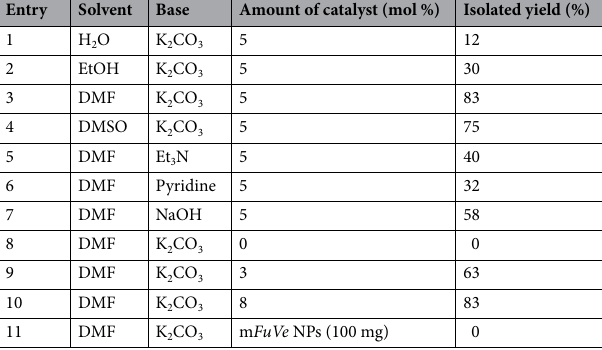
Table 1. Optimization conditions of the synthesis of N -cyclohexyl-2-(4-methyl-1-oxoisoquinolin-2(1 H )-yl)- 2-phenylacetamide. Reaction conditions: Compound 6 (0.3 mmol), base (0.6 mmol),